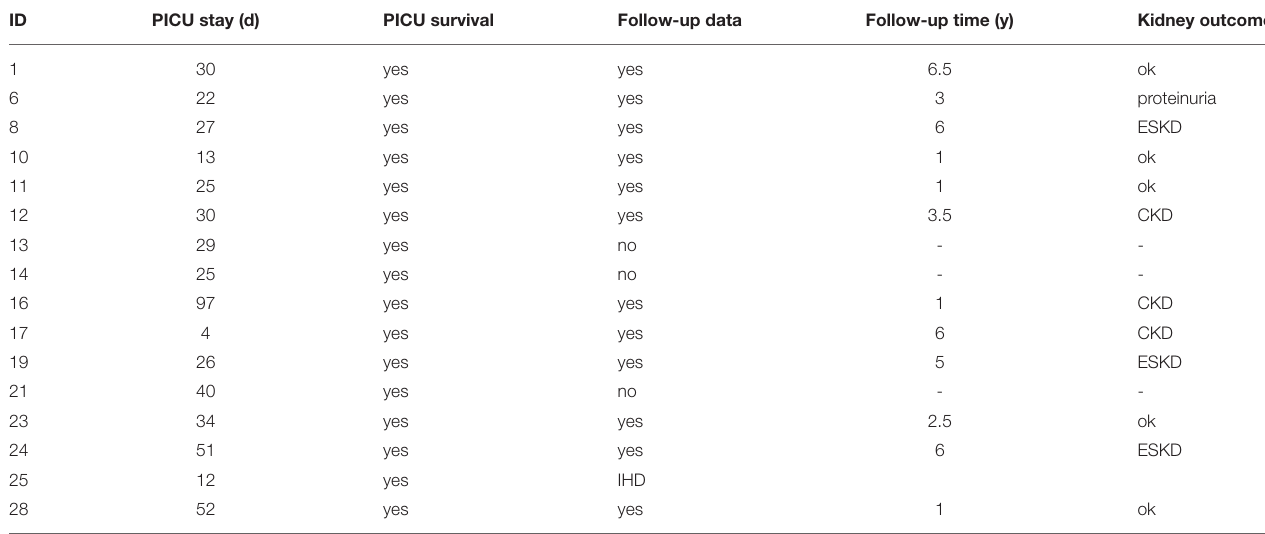
TABLE 4 | Long-term follow-up after pediatric intensive care unit survival. ID PICU stay (d) PICU survival Follow-up data Follow-up time (y) Kidney